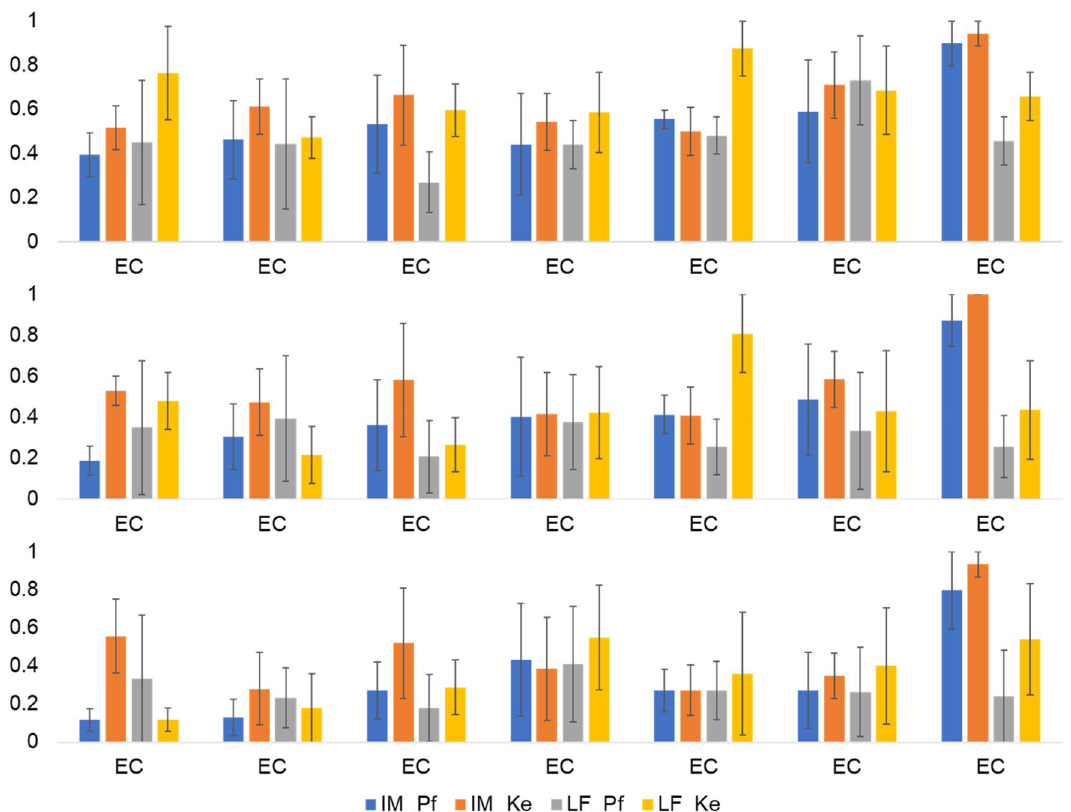
Figure 18. Phase desynchronization for LF and IM frequency band definitions based on Pfurtscheller (Pf) and Keller (Ke), and different thresholds in the control group ( N = 3). Ratio R φ>π/ 4 , ( B ) R φ> 3 π/ 8 and ( C ) R φ>π/ 2 shows a general increasing trend of phase desynchronization, however, no significant effects. Error bars show standard error of the